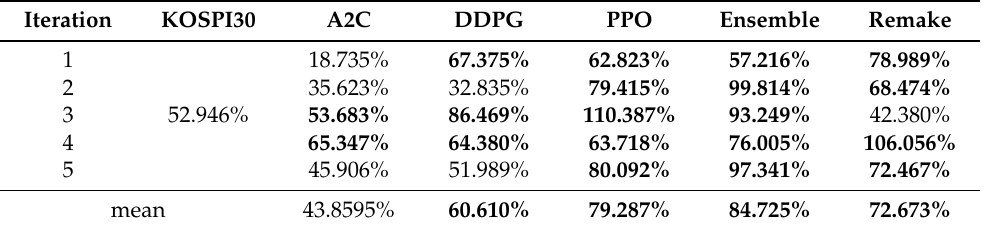
Table 4. Performance evaluation comparison for five agents after changing the trading strategy in the KOSPI market from 4 January 2016 to 13 August 2020 (1134 days).